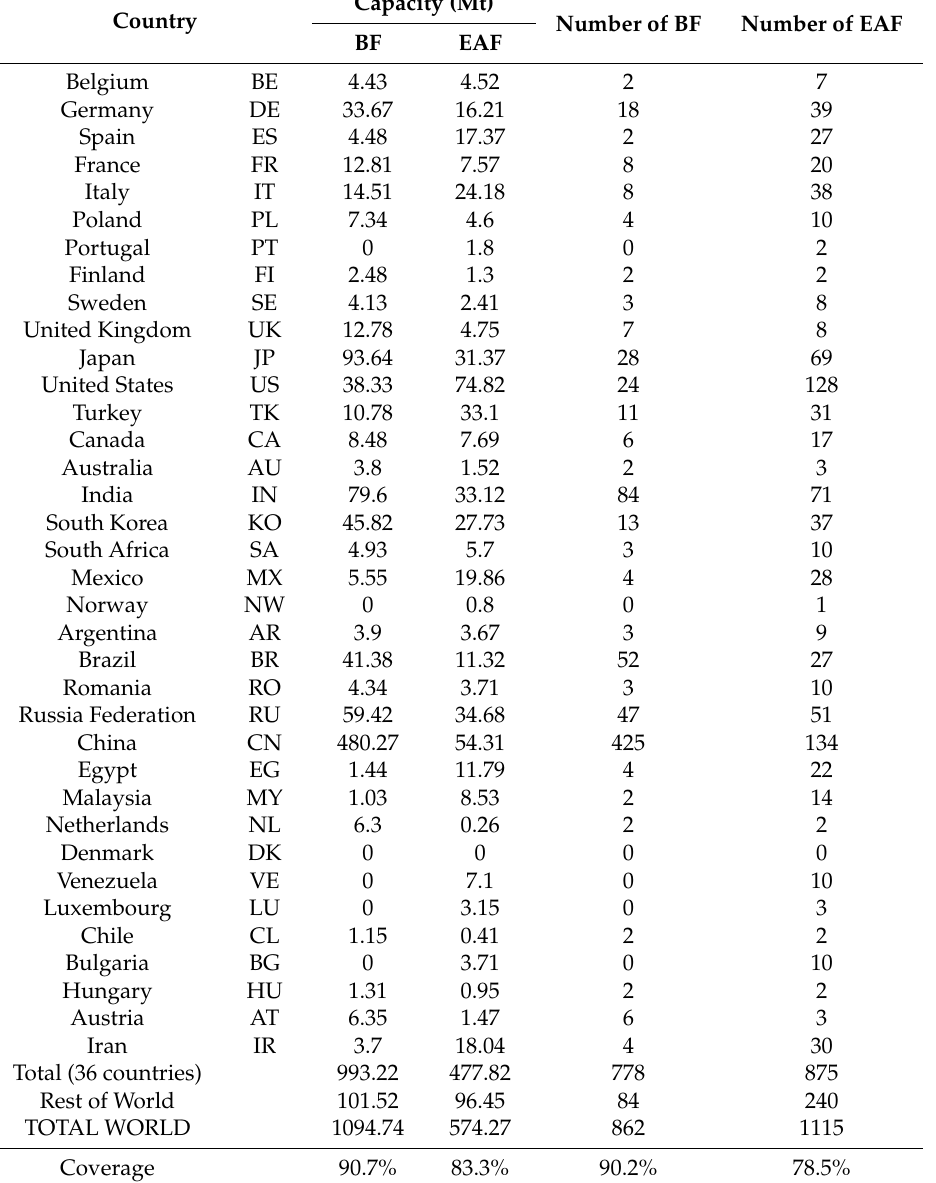
Table 3. Installed capacities and number of blast furnaces (BF) and AC and DC EAF in 2015 in the countries under